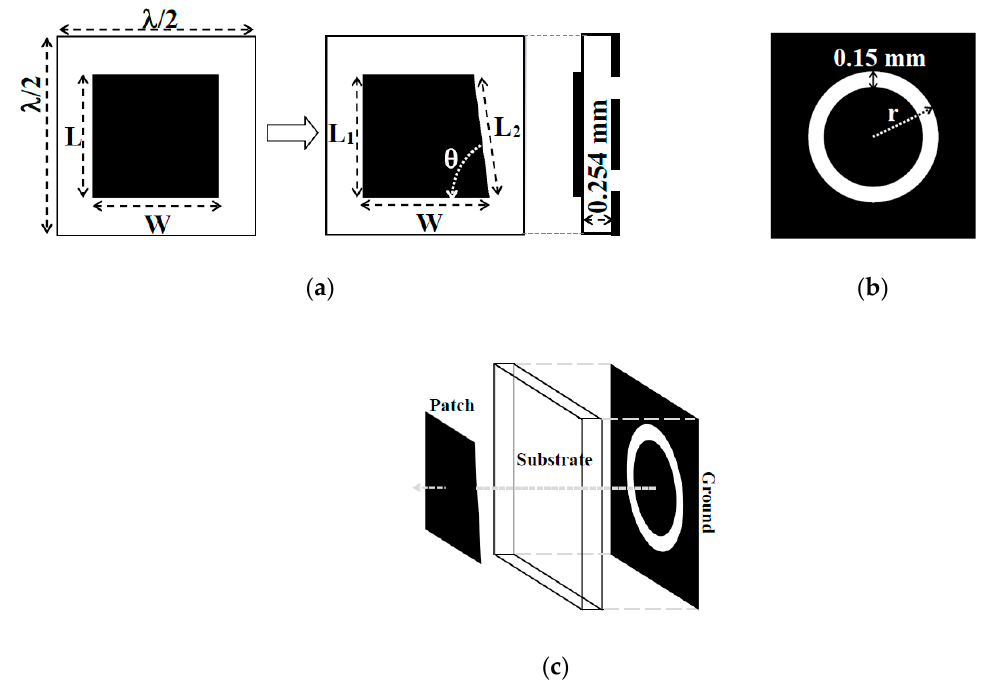
Figure 1. ( a ) Development of asymmetric patch element from a square patch element; ( b ) Ground ring slot; ( c ) Alignment of the asymmetric patch with ground ring slot.